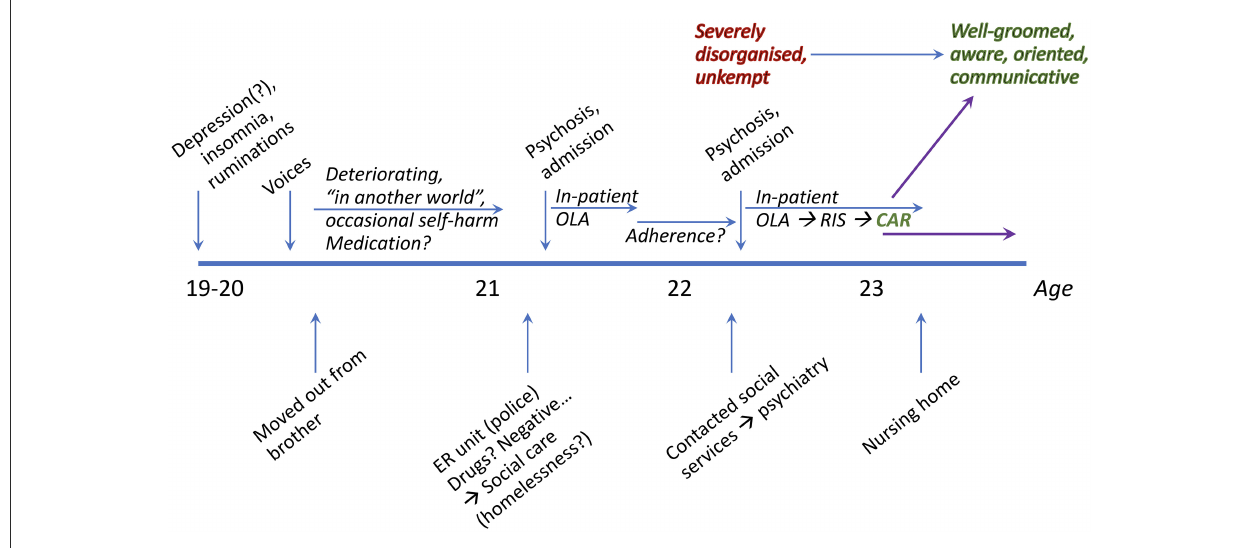
FIGURE1 Overview timeline of patient events and